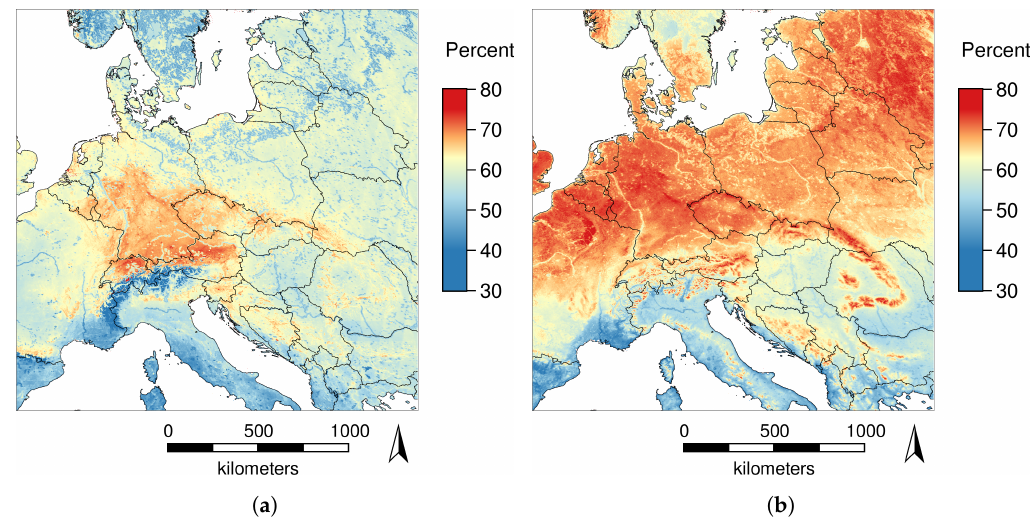
Figure 3. Percentage of missing LST pixel values aggregated for each time of day over all days and years: ( a ) at 01:30, 58.3% missing; and ( b ) at 13:30, 64.1%